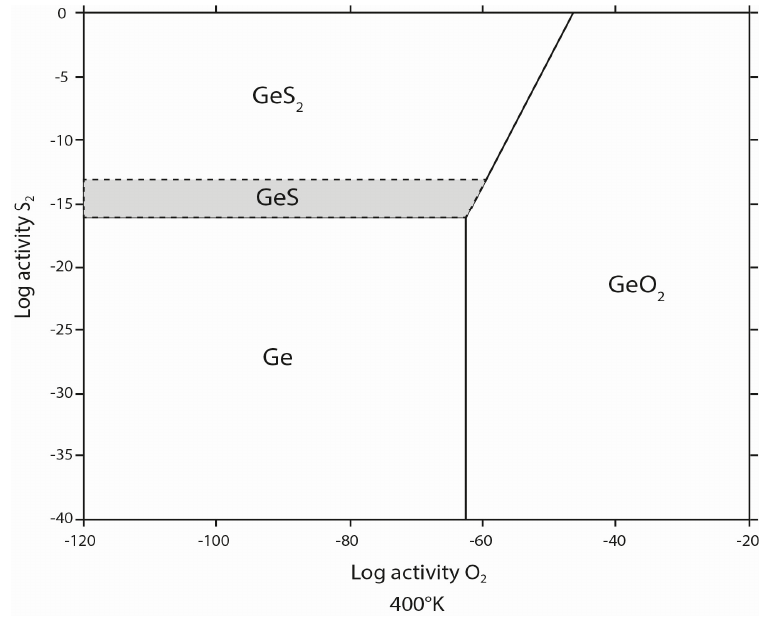
Figure 9. Diagram of Log S 2 versus Log O 2 for germanium species at 400 K, adapted from [3].